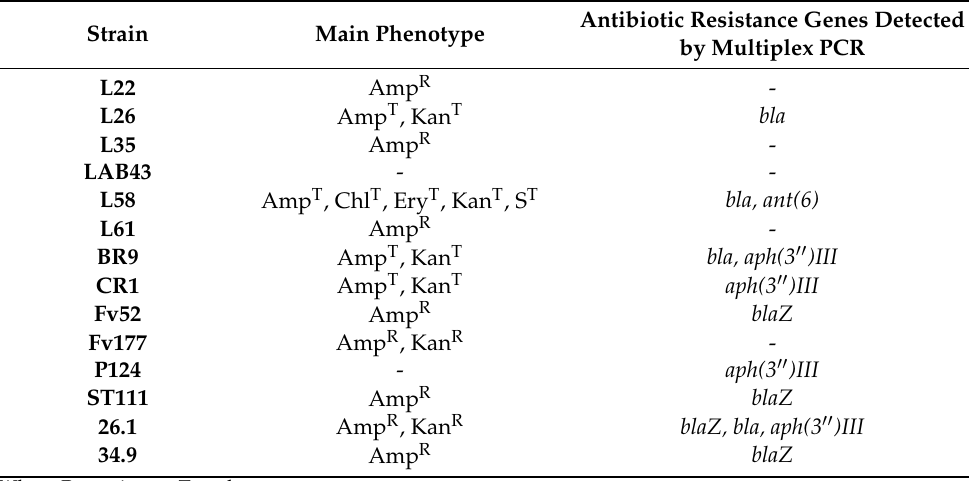
Table 7. Antibiotic resistance character in the analyzed LAB